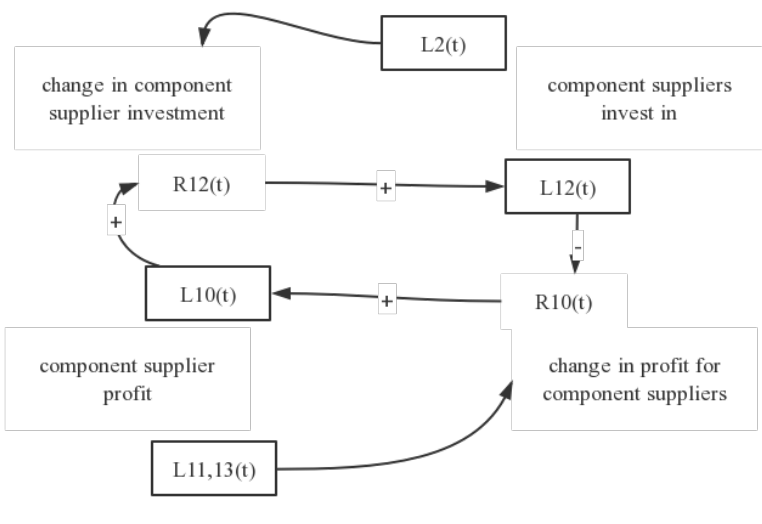
Fig. 1 Second order minimal fundamental mode.